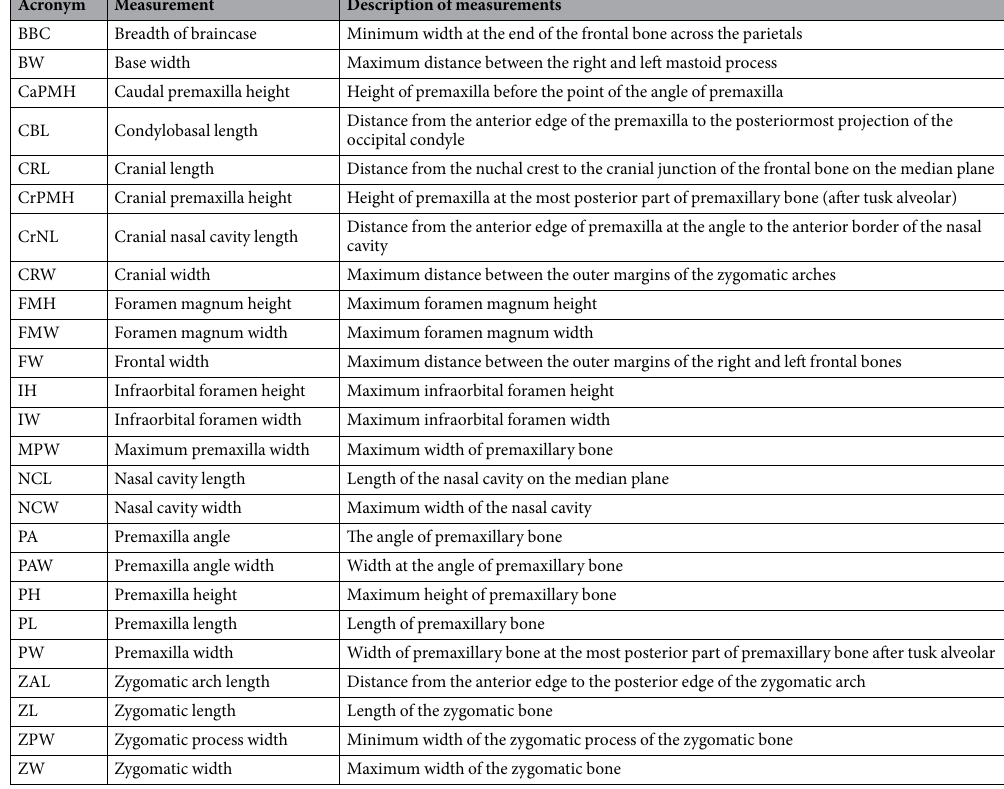
Table 1. Description of measurements taken from the dugong cranium (see Fig. 1).